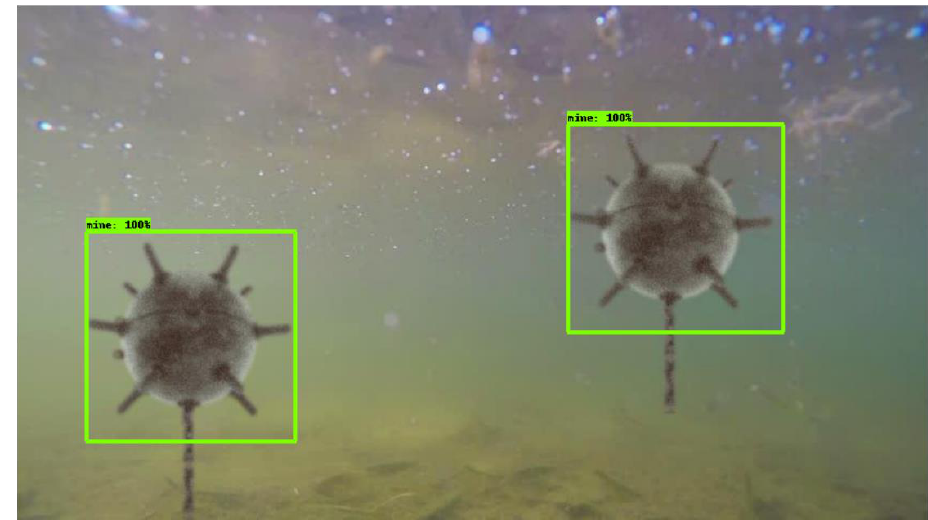
Figure 21. Underwater mine detection with EfficientDet.